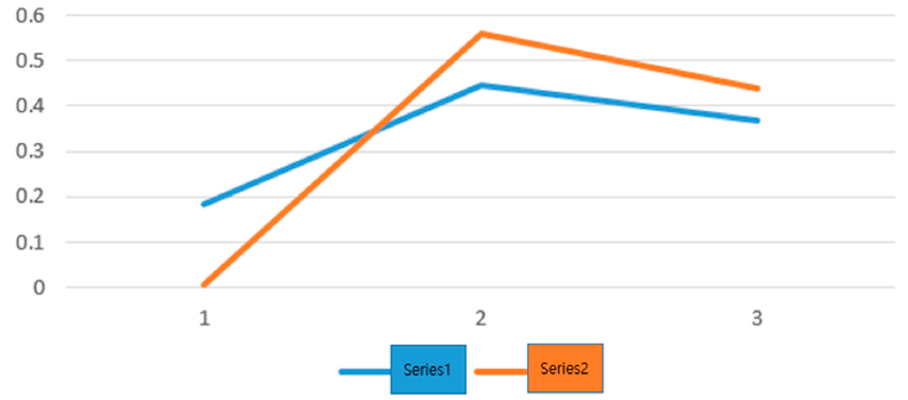
Figure 18. Comparison between the appearance frequency of “intense heat” and maximum power. (“Living Culture” section of Naver news, 2017).